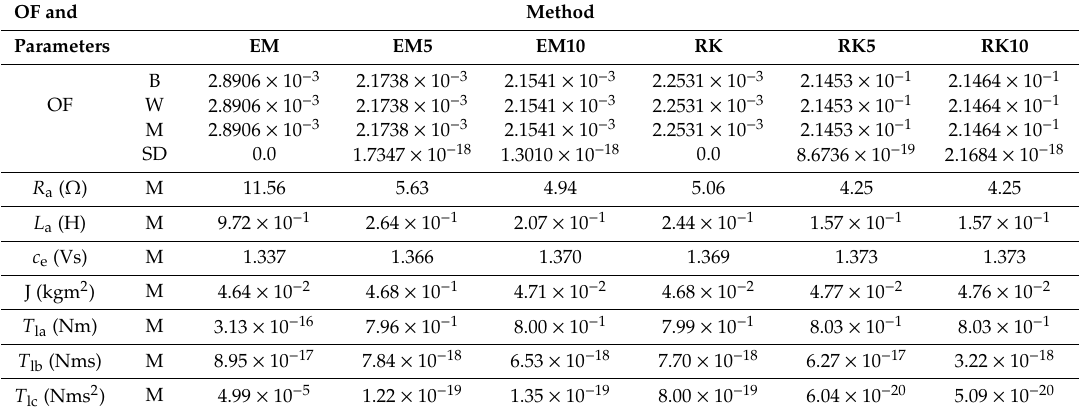
Table 24. OF and Mean value of the calculated parameters for 50 independent runs using EM, EM5, EM10, RK, RK5, and RK10 for MD1.